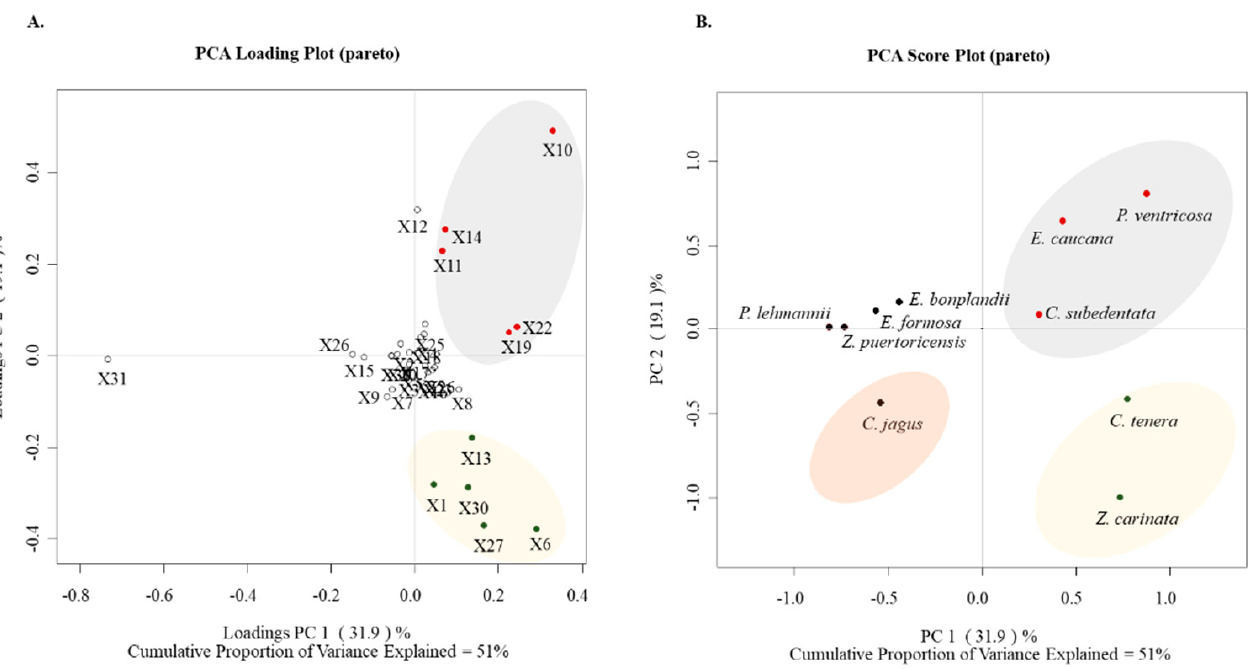
Figure 2. PCA based on the alkaloid profile of alkaloid fractions from Amaryllidaceae species. ( A ): PCA Loading Plot discriminating between alkaloid type and species; ( B ): PCA Score Plot discriminating between total alkaloid profile and species. Table 3 describes the codes assigned to the alka- loids.